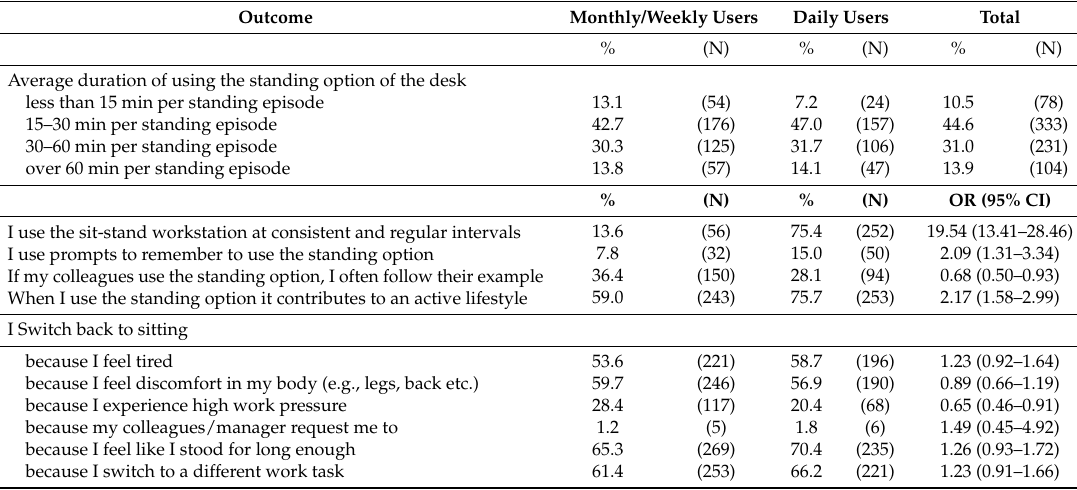
Table 2. Average duration of standing episodes and percentages of agreement with statements about the use of the sit-stand workstation and reasons to switch back to sitting for monthly/weekly users and daily users. Outcome Monthly/Weekly Users Daily Users Total % (N) % (N) %